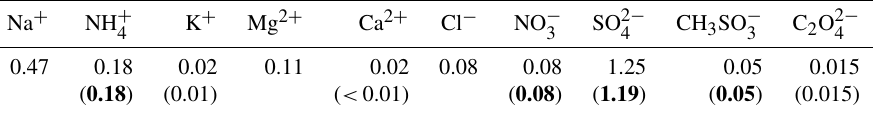
Table 1. Mean chemical composition of aerosol collected at Concordia from October to December (2006–2015). Values in bold and in parenthesis refer to the non-sea-salt components of aerosol. All concentrations are expressed in nEqm − 3 .